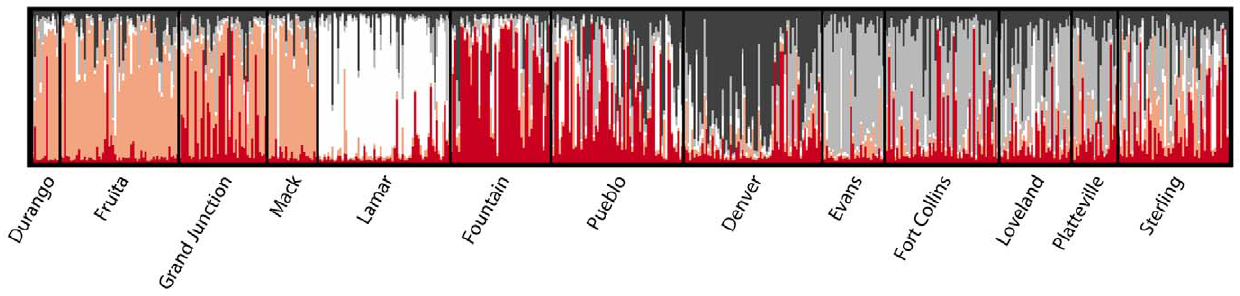
Figure 4. Structure diagram showing most likely number of clusters, K =5. Cluster membership was as follows: Cluster 1- Durango, Fruita, Grand Junction, Mack; Cluster 2– Lamar; Cluster 3– Fountain; Cluster 4– Denver; Cluster 5– Evans, Fort Collins, Loveland, Platteville. Pueblo and Sterling appear highly admixed. The program was run with the default parameters, (i.e. excluding population information) using a panel of 14